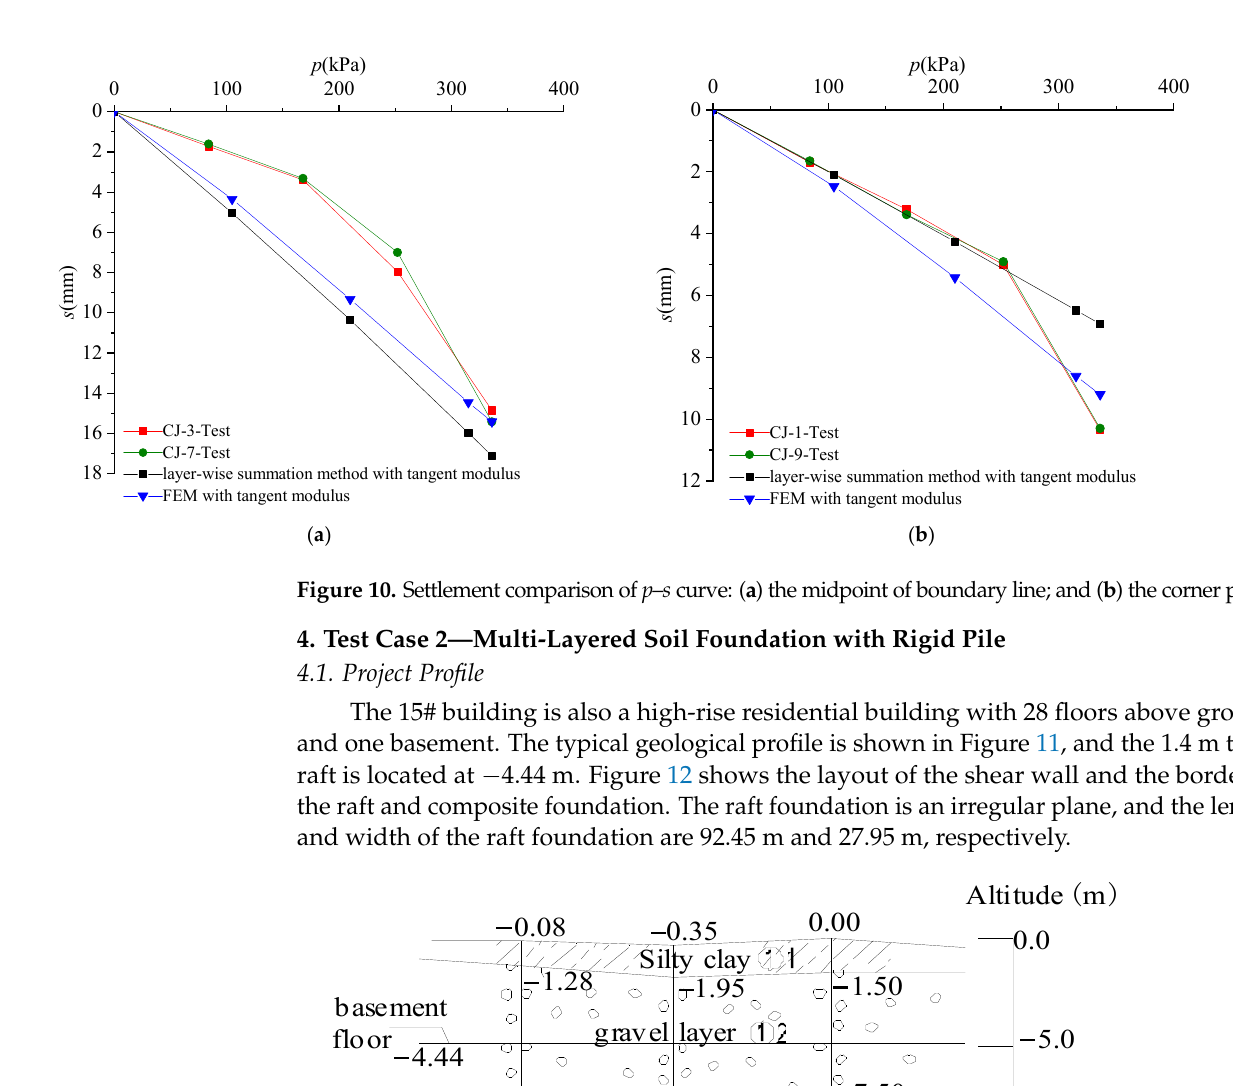
Figure 9. Vertical settlement contour of raft slab foundation of 9# building (m). The settlement at the corner points and midpoint of the raft boundary line were ex ‐ tracted and compared with the above. From Figure 10, it can be seen that the simulated settlement by the finite element method (FEM) is also close to the measured value, and the bending stiffness of the raft slab is considered in the FEM.